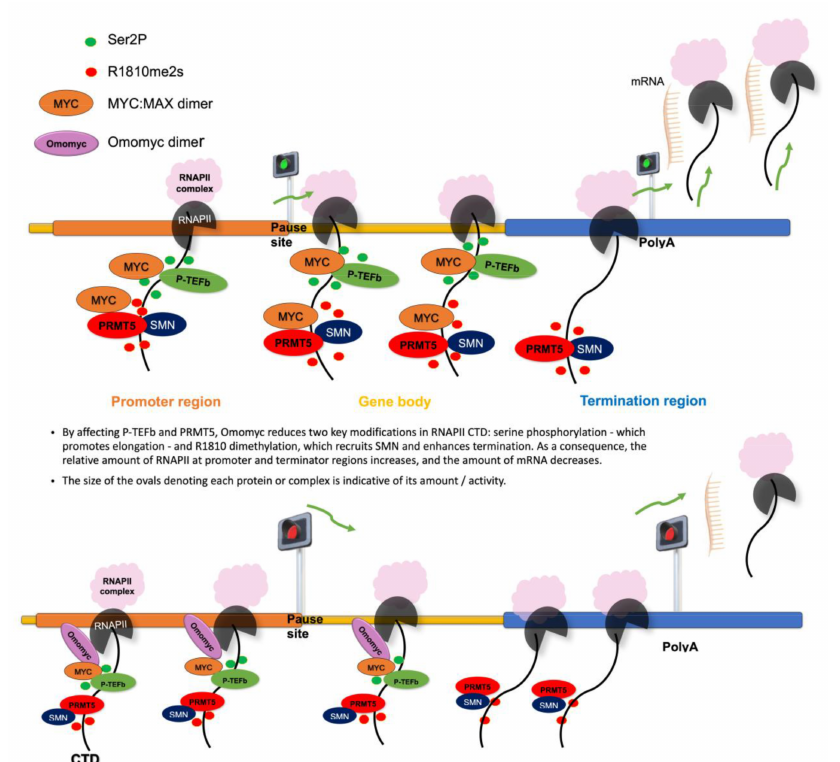
Figure 6. A model for MYC on RNAPII activity. Top: in the presence of high levels of MYC, RNAPII is widely distributed across regulators chromatin loci (both promoters and terminators) and gene bodies. Bottom: when MYC is inhibited, both pause-release and termination are rewired and RNAPII accumulates at promoters and transcription termination